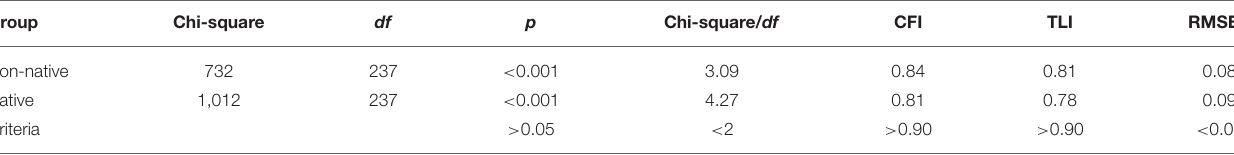
TABLE 1 | Observed fit statistics values and criteria for adequacy based on confirmatory factor analysis (CFA). Group